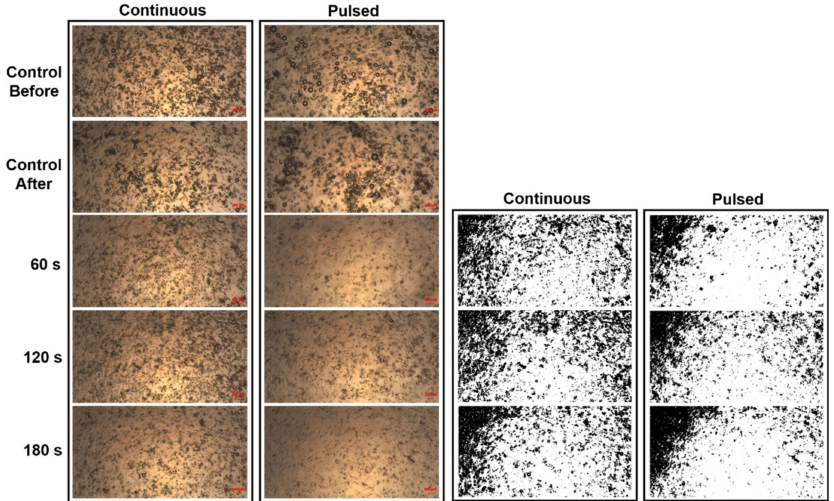
Figure 2. Microscopy images (two leftmost columns) of fivefold-diluted MBs without and with continuous- and pulsed-laser irradiation at 60, 120, and 180 s. The controls labeled as before and after refer to the original (fivefold-diluted) MBs and the MBs remaining on the slide after 180 s in the absence of laser irradiation. The microscopy images in the two rightmost columns are the images of the corresponding leftmost columns converted into grayscale images.